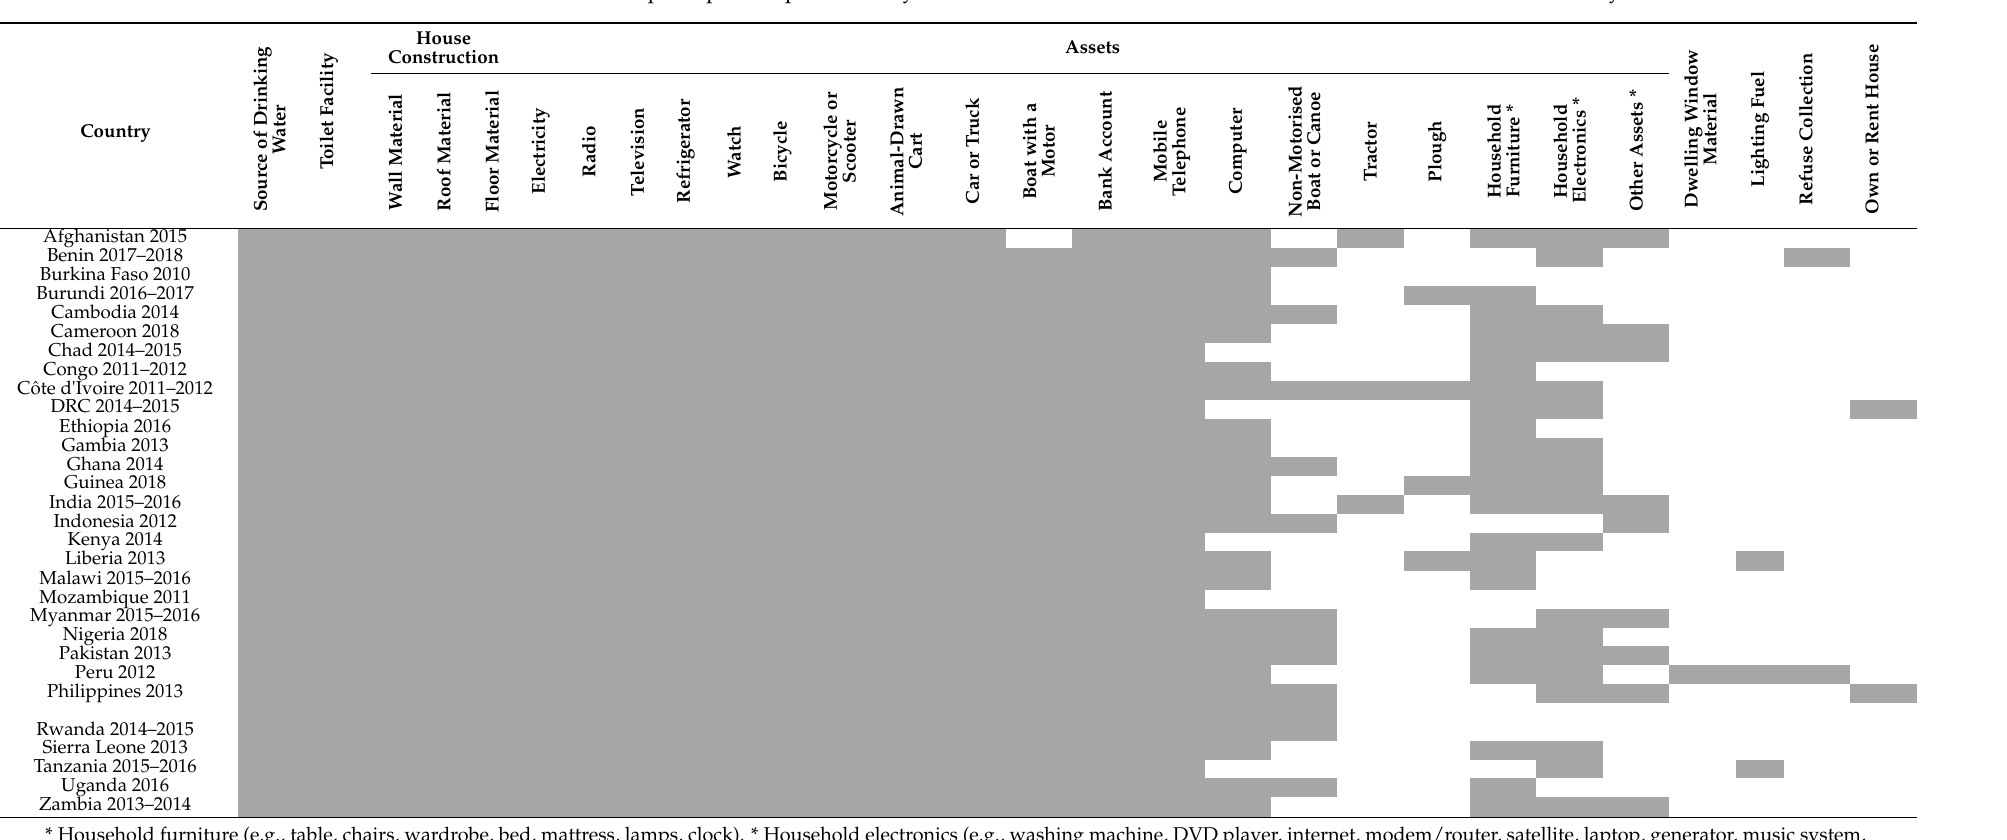
Table A1. Predictors included in the principal component analysis for the calculation of the modified wealth index within each